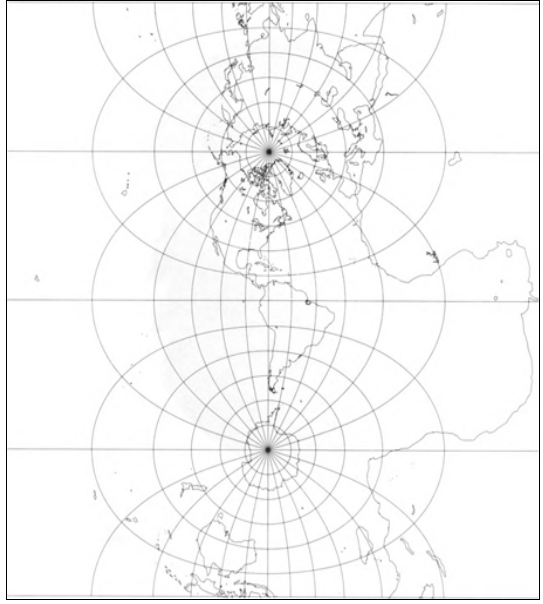
Figure 4: Transverse Mercator projection, central meridian